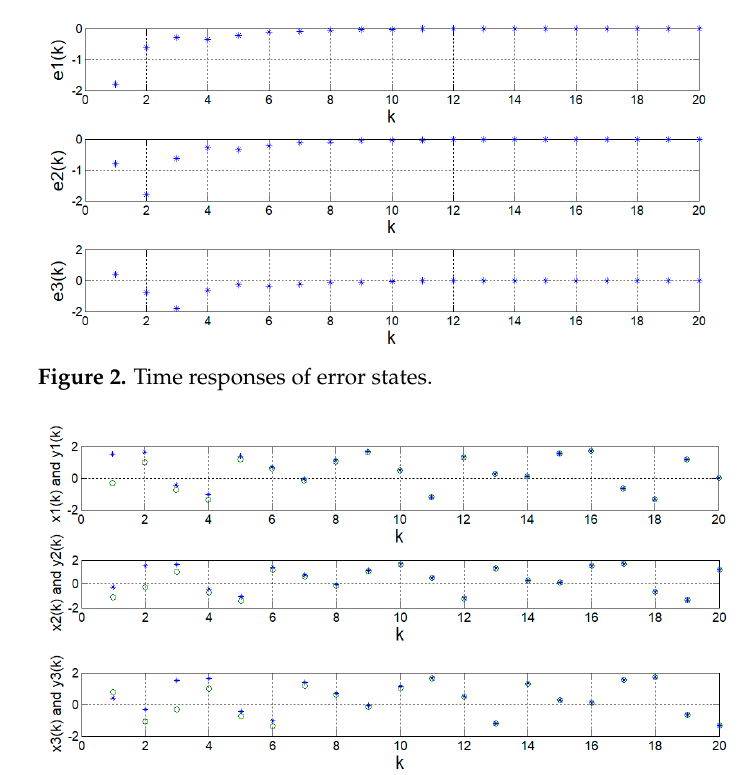
Figure 3. Time responses of controlled